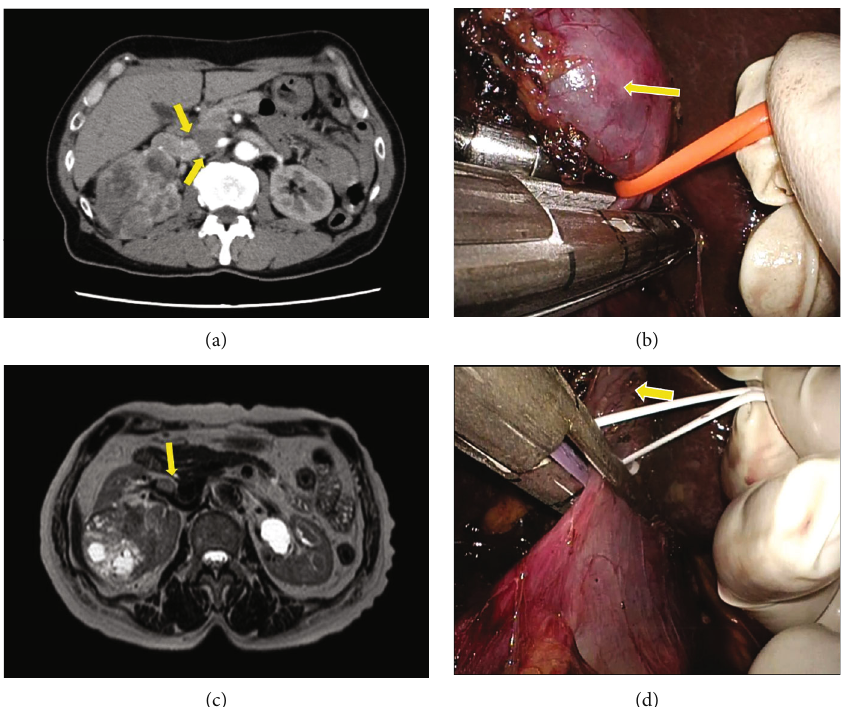
Figure 3: Imaging and intraoperative fi ndings of the cases of right renal cell carcinoma (RCC) with thrombus ((a, b) case 1 and (c, d) case 2). (a) Computed tomography demonstrated a renal tumor thrombus extending 0.5cm into the inferior vena cava. (b) The tumor was pulled up within the renal vein using the vessel loop, and the renal vein was divided using the Endo GIA stapler. (c) Magnetic resonance imaging demonstrated a renal tumor thrombus within the renal vein. (d) The tumor was pulled up using the vessel loop, and the renal vein was divided using the Endo GIA stapler. Arrowheads indicate the tip of the tumor thrombus.